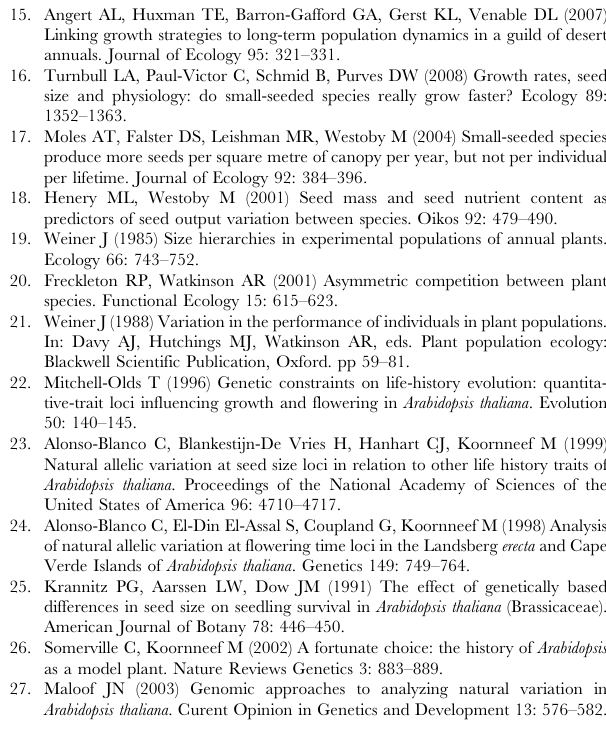
Table S1 Information about the 32 lines selected for the study.